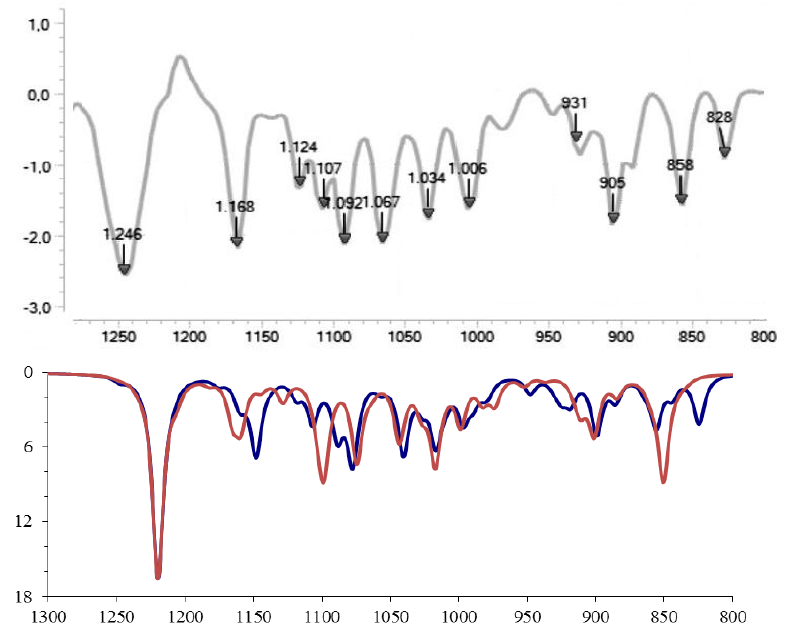
Figure 3. Comparison of the superposition of simulated infrared spectra (fingerprint region) of diastereomers 1 (blue) and 4 (red) (bottom) with experimental data (top).